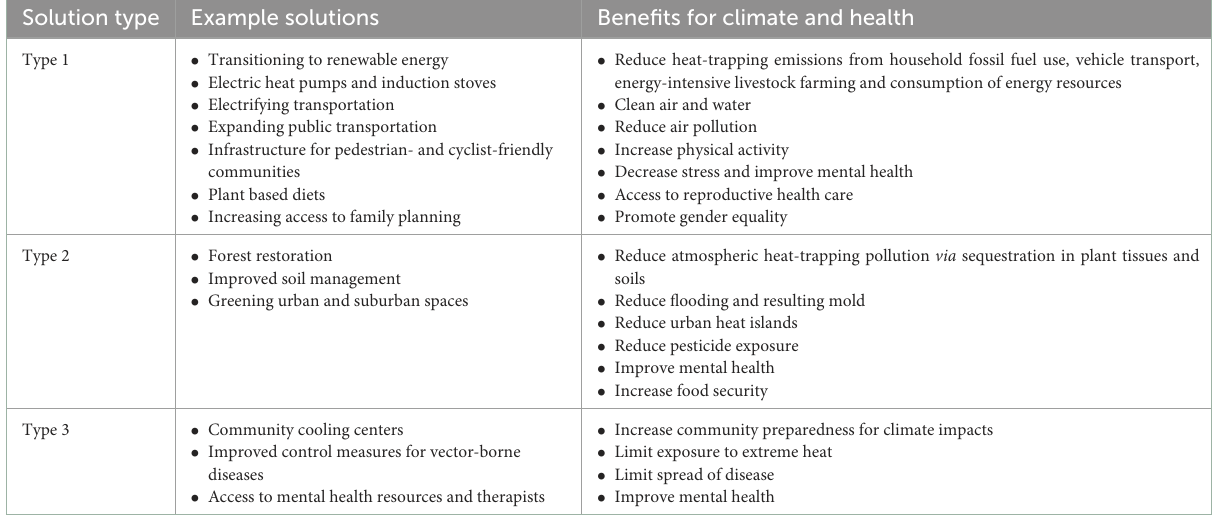
TABLE 1 Summary of example climate solutions and adaptation measures with related climate and health